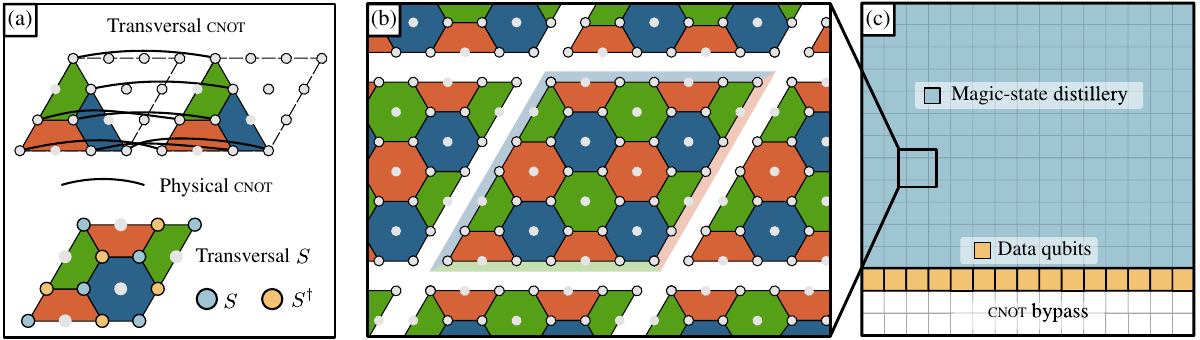
H ⊗ n , the logical S gate S FIG. 9. (a) Color codes feature transversal Clifford gates. While the logical Hadamard gate is simply H L ¼ L is a mixture of physical S and S † gates. Using a bicoloration of the physical qubits, such that the sublattice involving the corner qubits is requires physical S gates on blue qubits and an S † gate on orange qubits. The logical CNOT gate blue and the other one is orange, S L corresponds to n physical CNOT s between pairs of qubits from two triangles. (b) Since this requires the movement of ancilla qubits from one triangle to the other, this leaves some unused space in between, which can be used for the diamond color codes. These form a square lattice of logical qubits. (c) Universal fault-tolerant quantum computation can be achieved on a line of data qubits with a magic-state distillery and a CNOT